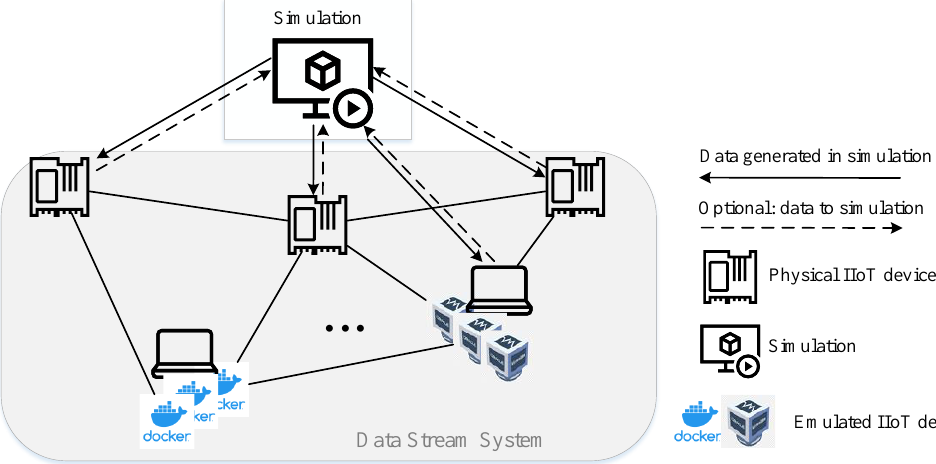
Figure 6. Architecture 2: several networked devices combined with one